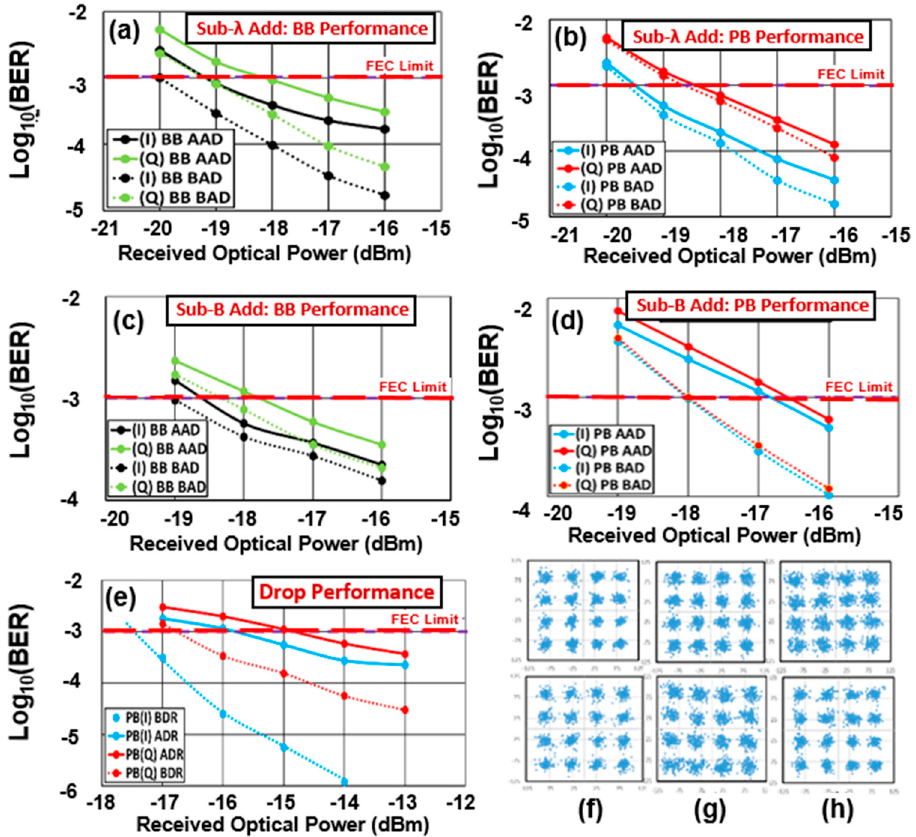
Figure 9. BER curves for ( a , b ) each Sub-B before/after Sub- λ add; ( c , d ) each Sub-B before/after Sub-B add; ( e ) before/after the drop operation; Example subcarrier constellations at − 18 dBm for the BB-I (upper) and PB-I (lower) after ( f ) Sub- λ add; ( g ) after Sub-B add; example subcarrier constellations at − 14 dBm after the drop operation for ( h ) PB-I (upper) and PB-Q (lower).